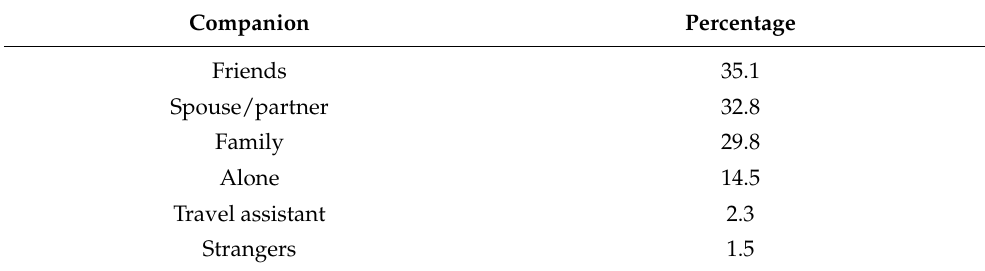
Table 2. Most popular companion during travel when taking trips with at least one overnight